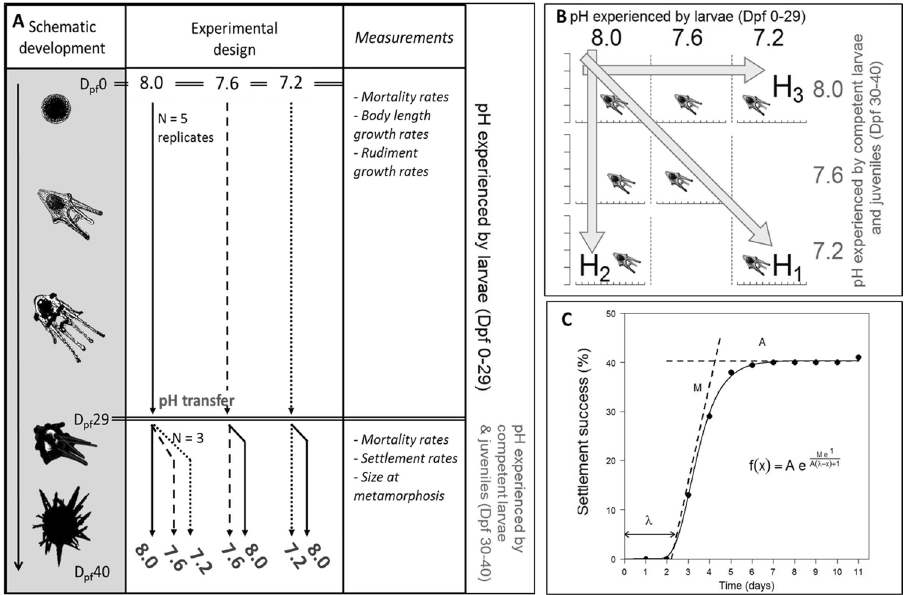
Figure 1. ( A ) Timeline of the experiment. The experiment started (Day post-fertilization, Dpf 0) with cleaving embryos that were distributed into five replicate jars at three different pHs (8.0, 7.6 and 7.2). At Dpf 29, larvae from three of the five replicate jars were distributed individually into wells inside three 24-well plates per new pH condition (i.e., n = 72 larvae for each treatment). ( B ) Experimental design: Two parameters were tested: (i) pH experienced by larvae (Dpf 1 to 29) and (ii) pH experienced by stages from competent larvae to juveniles (Dpf 30–40). Seven combinations were tested allowing to test three different hypotheses: (H 1 ),